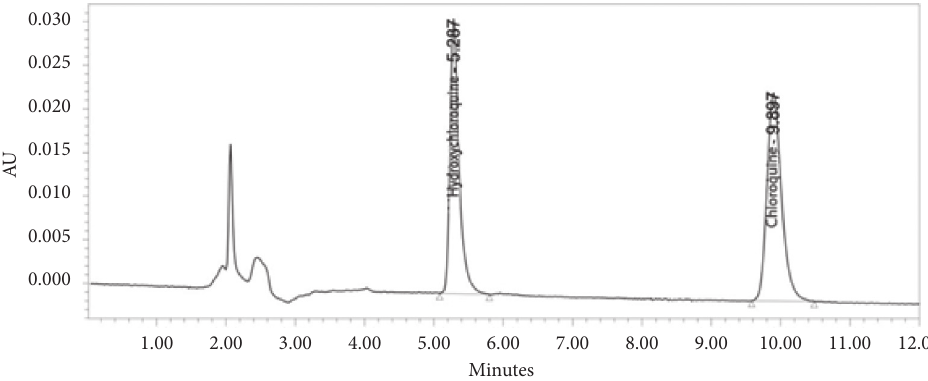
Figure 1: Chromatogram from the system suitability test. Table 1: Data of the system suitability test.